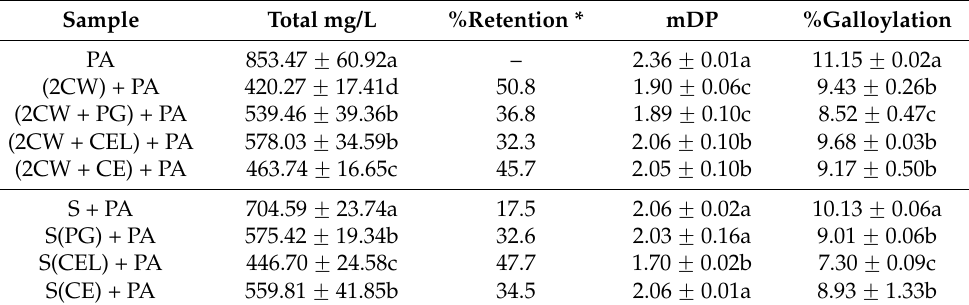
Table 2. Concentration and composition of the remaining PAs in solution after the interaction with enzyme pretreated CWs ((2CW)) or with the supernatant solution (S).